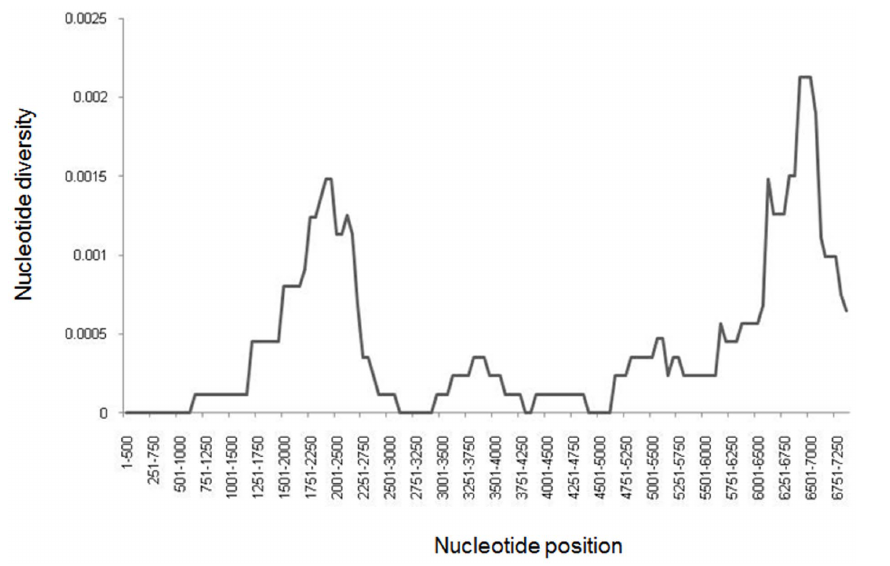
Figure 3. Nucleotide variability among strains of outbreak D. The graph was constructed using sliding window of 500 nt and steps of 250 nt.